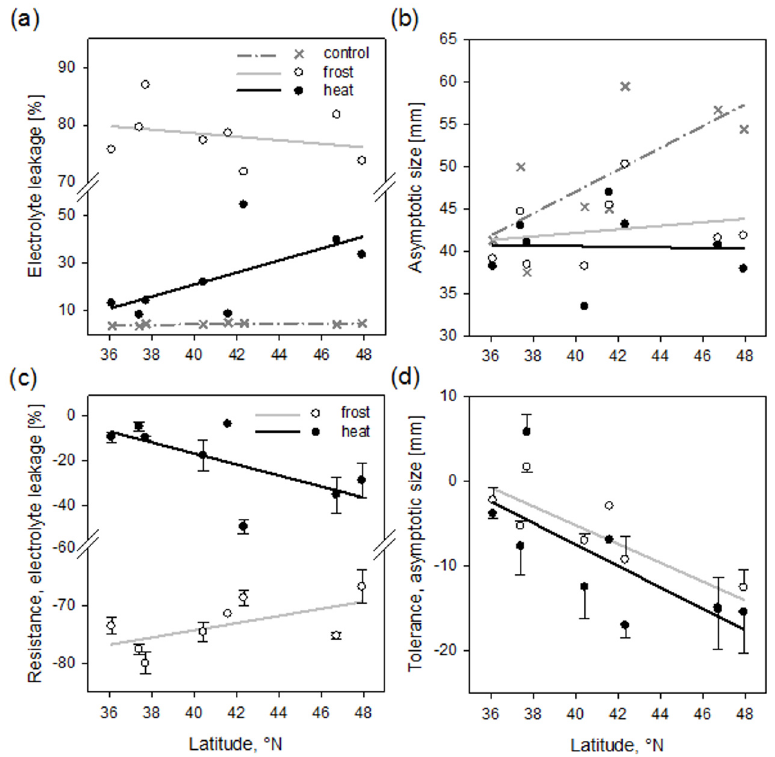
Fig 2. Latitude of origin of Arabidopsis lyrata plants differing in electrolyte leakage (a), asymptotic size (b), resistance to frost and heat based on electrolyte leakage (c), and tolerance to frost and heat based on asymptotic size (d). Symbols depict population means based on family means and one-/two- sided bars indicate standard errors. Regression lines on panels a and b represent the significant or close to significant latitude-by-treatment interaction, regression lines on panels c and d represent significant latitude effect. For statistics see Tables 1 and 2. Data for heat tolerance and frost resistance had been corrected for ancestral